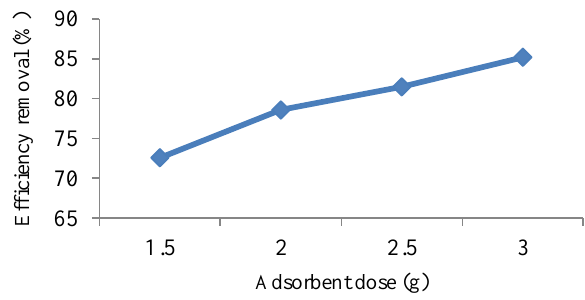
Fig. 1. The removal efficiency based on the various adsorbent concentrations